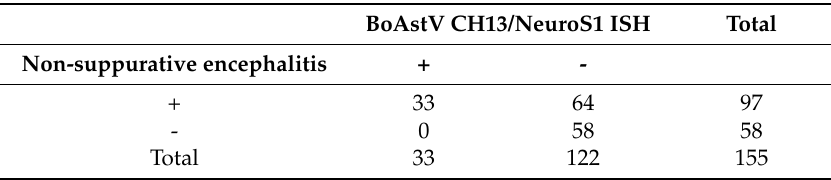
Table 1. Frequency of the bovine astrovirus (BoAstV) CH13/NeuroS1 detection in cases of non ‐ suppurative bovine encephalitis and a control group by in situ hybridization (ISH). The BoAstV CH13/NeuroS1 was detected only in diseased animals with a significant statistical correlation, but not in control animals previously diagnosed as healthy or as encephalitis of bacterial origin. BoAstV CH13/NeuroS1 ISH